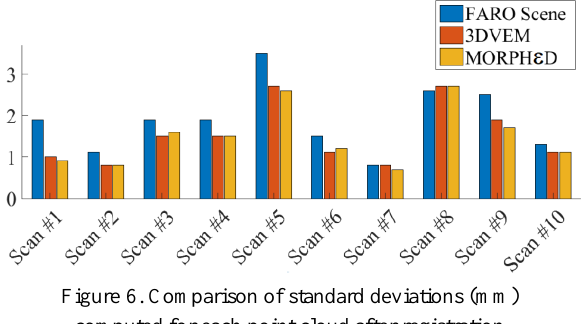
Figure 6. Comparison of standard deviations (mm) computed for each point cloud after registration